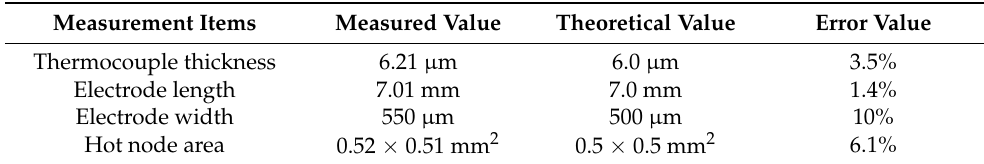
Figure 7. Physical view of P6 Stylus Profiler. Table 1. The measurement results for the thin-film thermocouple.